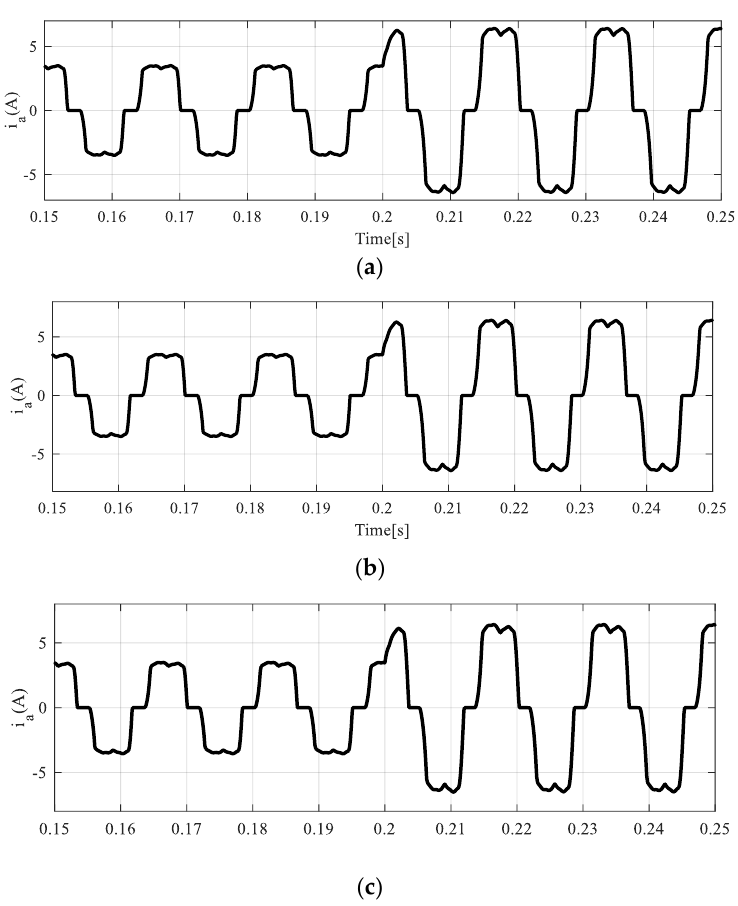
Figure 14. The output currents of phase “a” for the ( a ) first controller, ( b ) second controller, and ( c ) third controller.